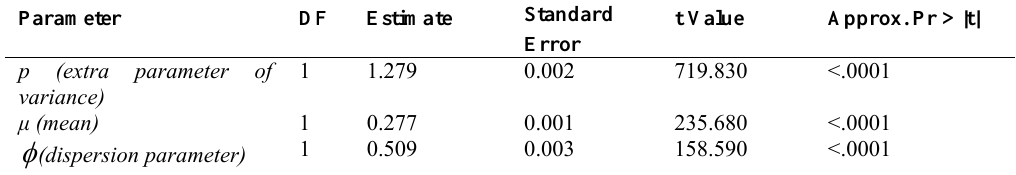
Table 5 : Parameter Estimates for Tweedie Distribution (entire period 2008–2014)